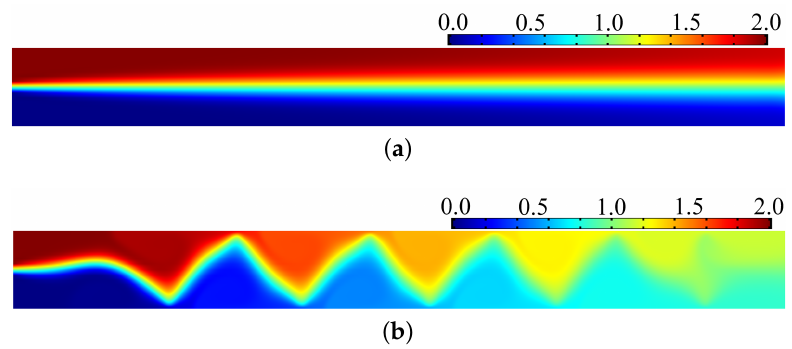
Figure 6. ( a ) Concentration distribution in the microchannel without electrode potential, where the value of the mixing measurement is 0.6; ( b ) concentration distribution with the electrode potential shown in Figure 5a, and the corresponding value of the mixing measurement is 0.015, which is lower than the threshold level of mixing, defined as 0.050 [8]. Therefore, complete mixing is achieved when the electrode potential obtained using optimal control method is imposed on the sidewalls of the electroosmotic micromixer in Figure 3.